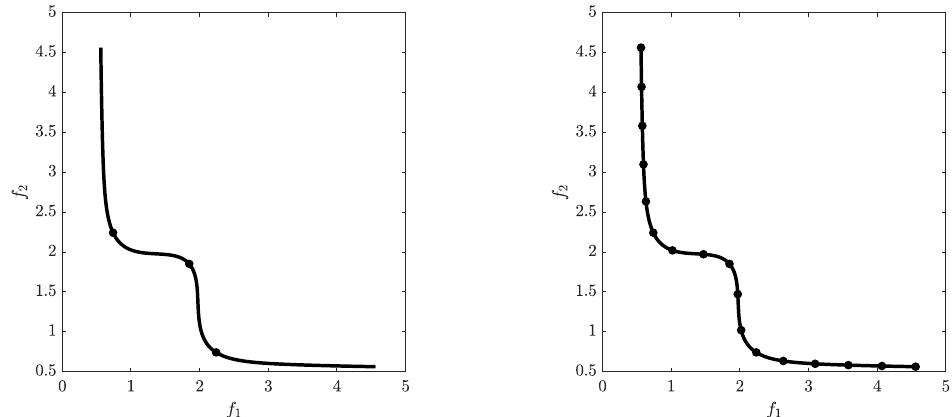
Figure 1. Gaps in the approximation can occur when (cid:101) -dominance is used exclusively in the selec- tion/archiving of the candidate solutions ( left ). ∆ -tight (cid:101) -(approximate) Pareto fronts also consider the distance of the Pareto front toward the archive ( right